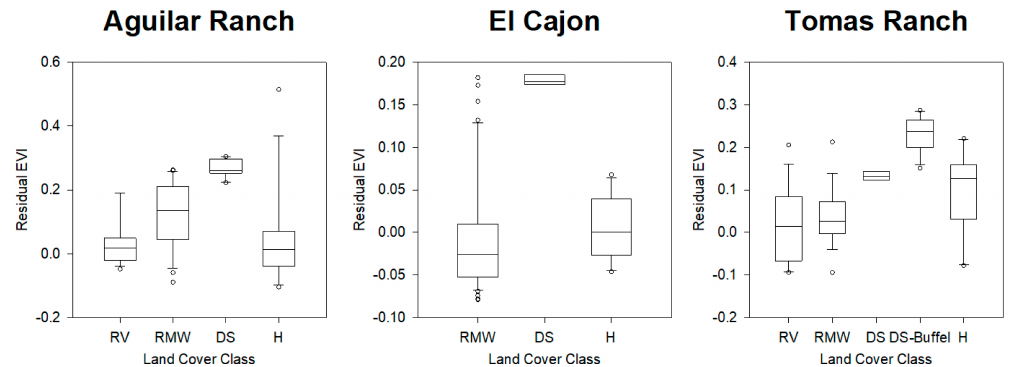
Figure 8. Differences among residual values of each land cover class in Aguilar Ranch, El Cajon and Tomas Ranch. RV (Riparian Vegetation), RMW (Riparian Mesquite Woodland), DS (Desert Scrub), H (Herbaceous cover). Aguilar Ranch: H = 28.23, P ≤ 0.001, N = RV(16) RMW(24) DS(11) H(13). El Cajon: H = 14.76, P ≤ 0.001, N = RMW(44) DS(5) H(14). Tomas Ranch: H = 33, P ≤ 0.001, N = VR(17) MR(15)